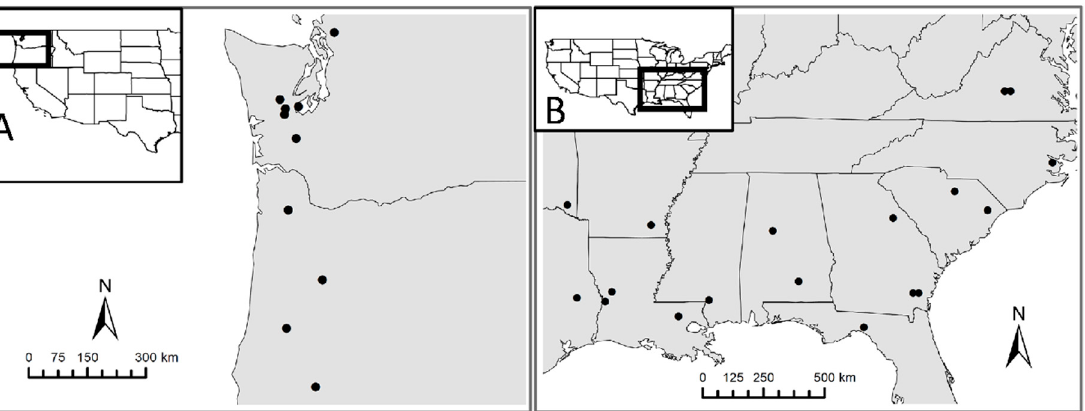
Figure 1. Map of the NSF CAFS 15N fertilization sites for: ( a ) Douglas-fir plantations in the Pacific Northwest region of the United States; ( b ) loblolly pine sites of the southeastern United States.